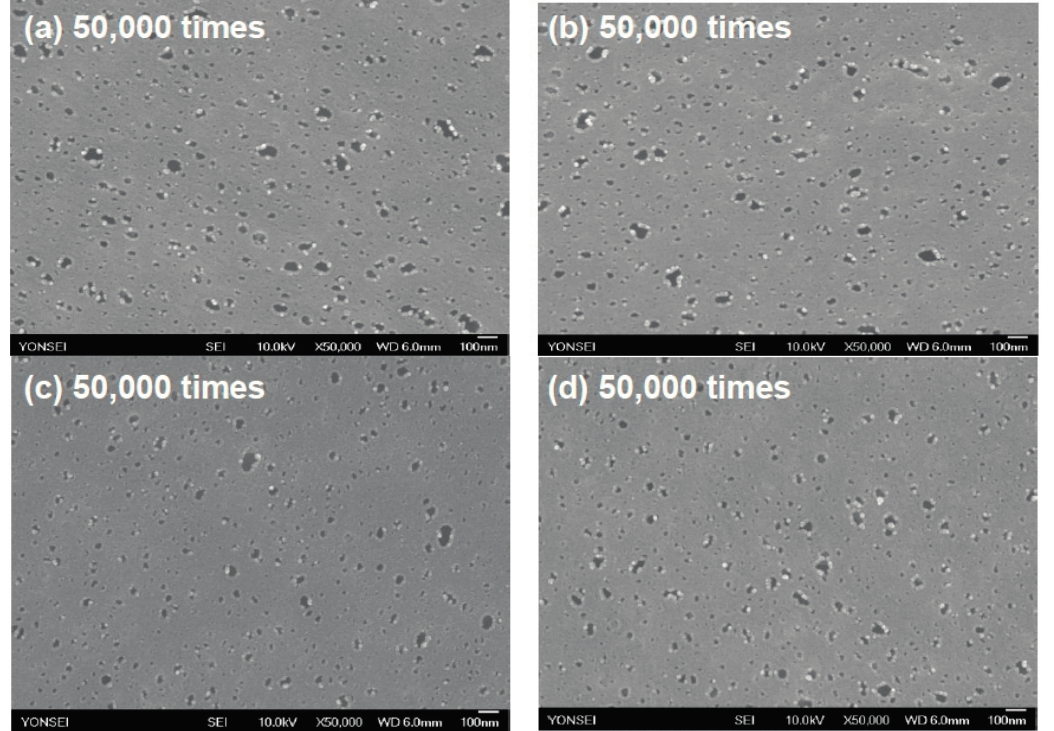
Figure 6. SEM images: surface of ( a ) A-1; ( b ) A-2; ( c ) B-1, and ( d ) B-2 membranes.